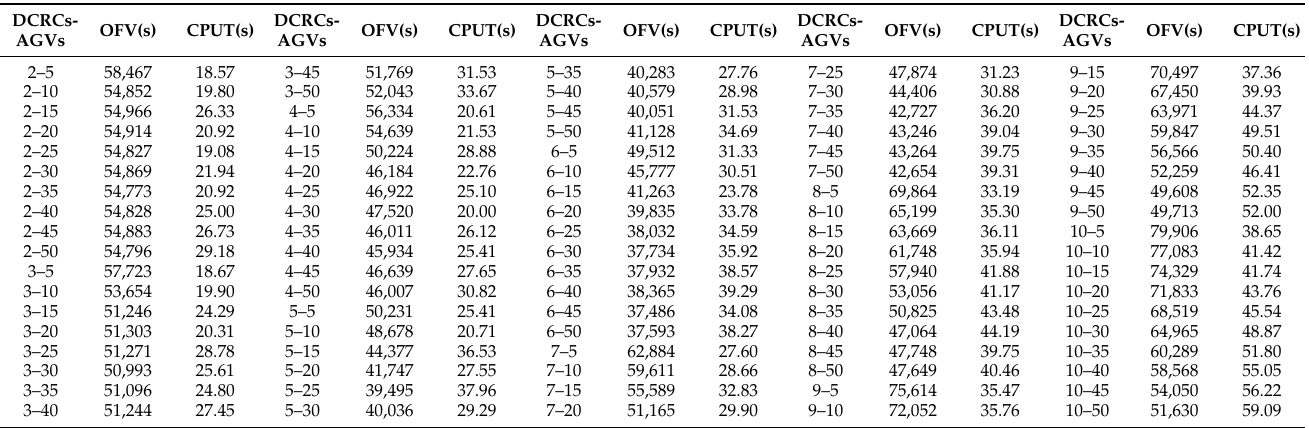
Table 5. Calculation example of 3